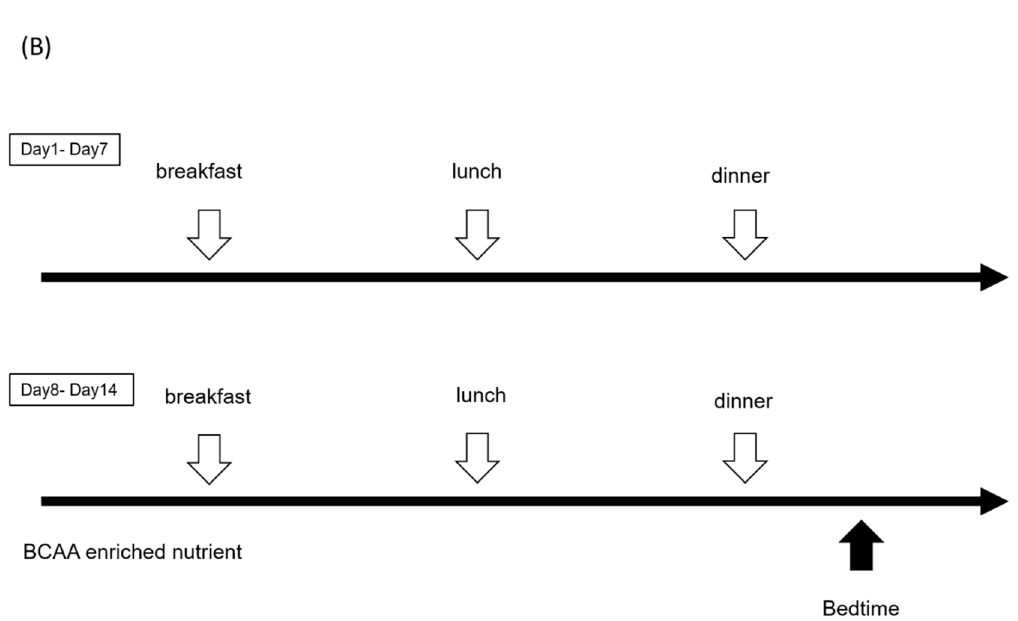
Figure 1. Study protocol: ( A ) Blood glucose (BG) levels were determined every 15 min for 14 days (day1–day14) with the Flash Glucose Monitoring (FGM) system. The FMG system was attached on day 1 and detached on day 15. The patients underwent blood examination on day 8. ( B ) BCAA-EN was administered at bedtime for 1 week (day 8–day 14) in all 13 patients with cirrhosis. BCAA, branched-chain amino acid; FMG, Flush Glucose Monitoring.